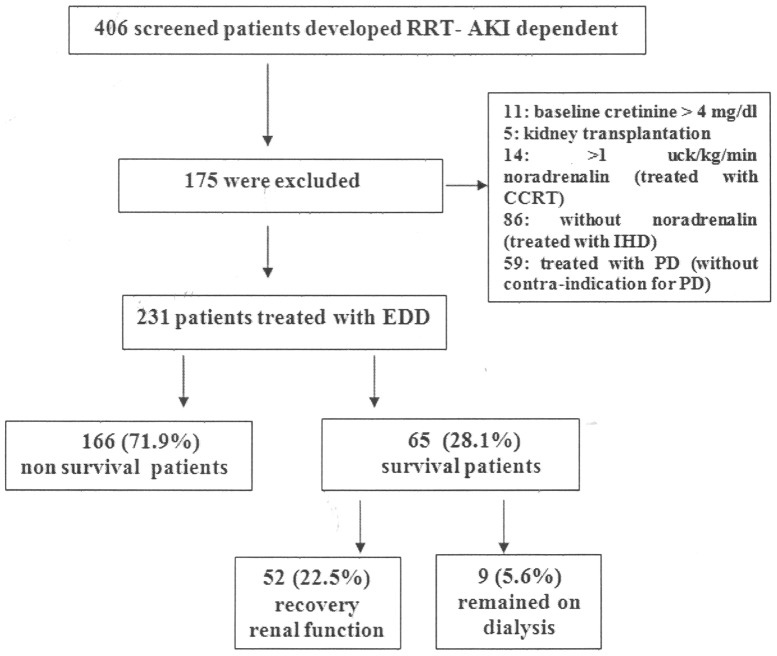
Inclusion and outcome of patients enrolled in the study.